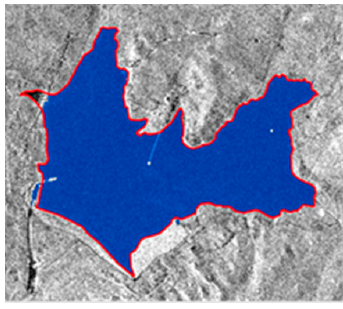
Figure 9. CSK acquired on the 8 February 2012, over-imposed a polygon extracted from the classification procedure (in blue) and a hand-digitized water surface (red boundary). Water levels resulting from SAR, ASTER and LS5 processing are compared to water levels measured in situ (Figure 10a–c, respectively).